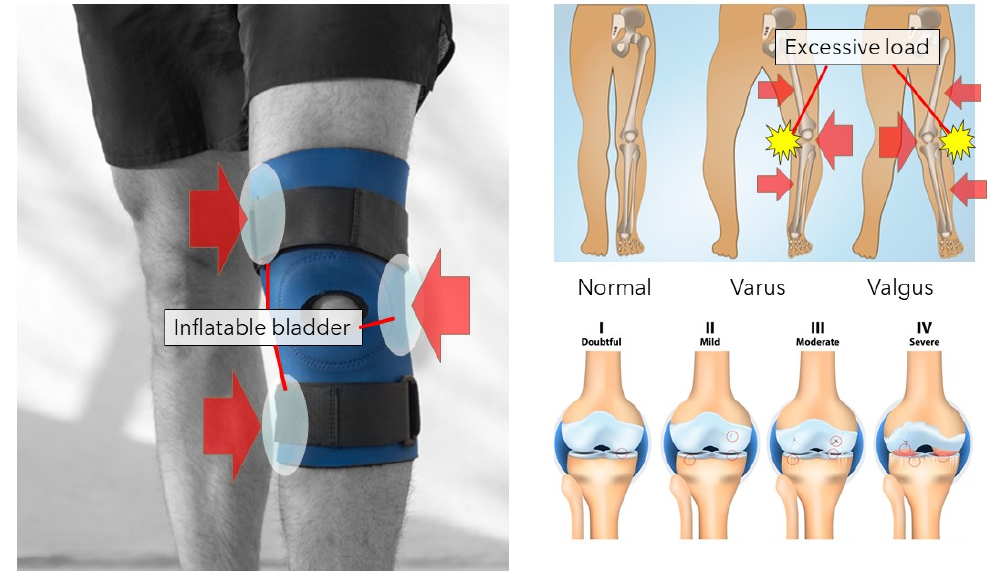
Figure 3. ( Left ): Passive mechanics of a knee brace for varus OA. ( Top right ): Types of knee deformity and required kinetic support indicated by arrows. ( Bottom right ): Levels of knee OA micro-fracture indicated within red circles with more severe conditions showing reduced joint space and diminished articular